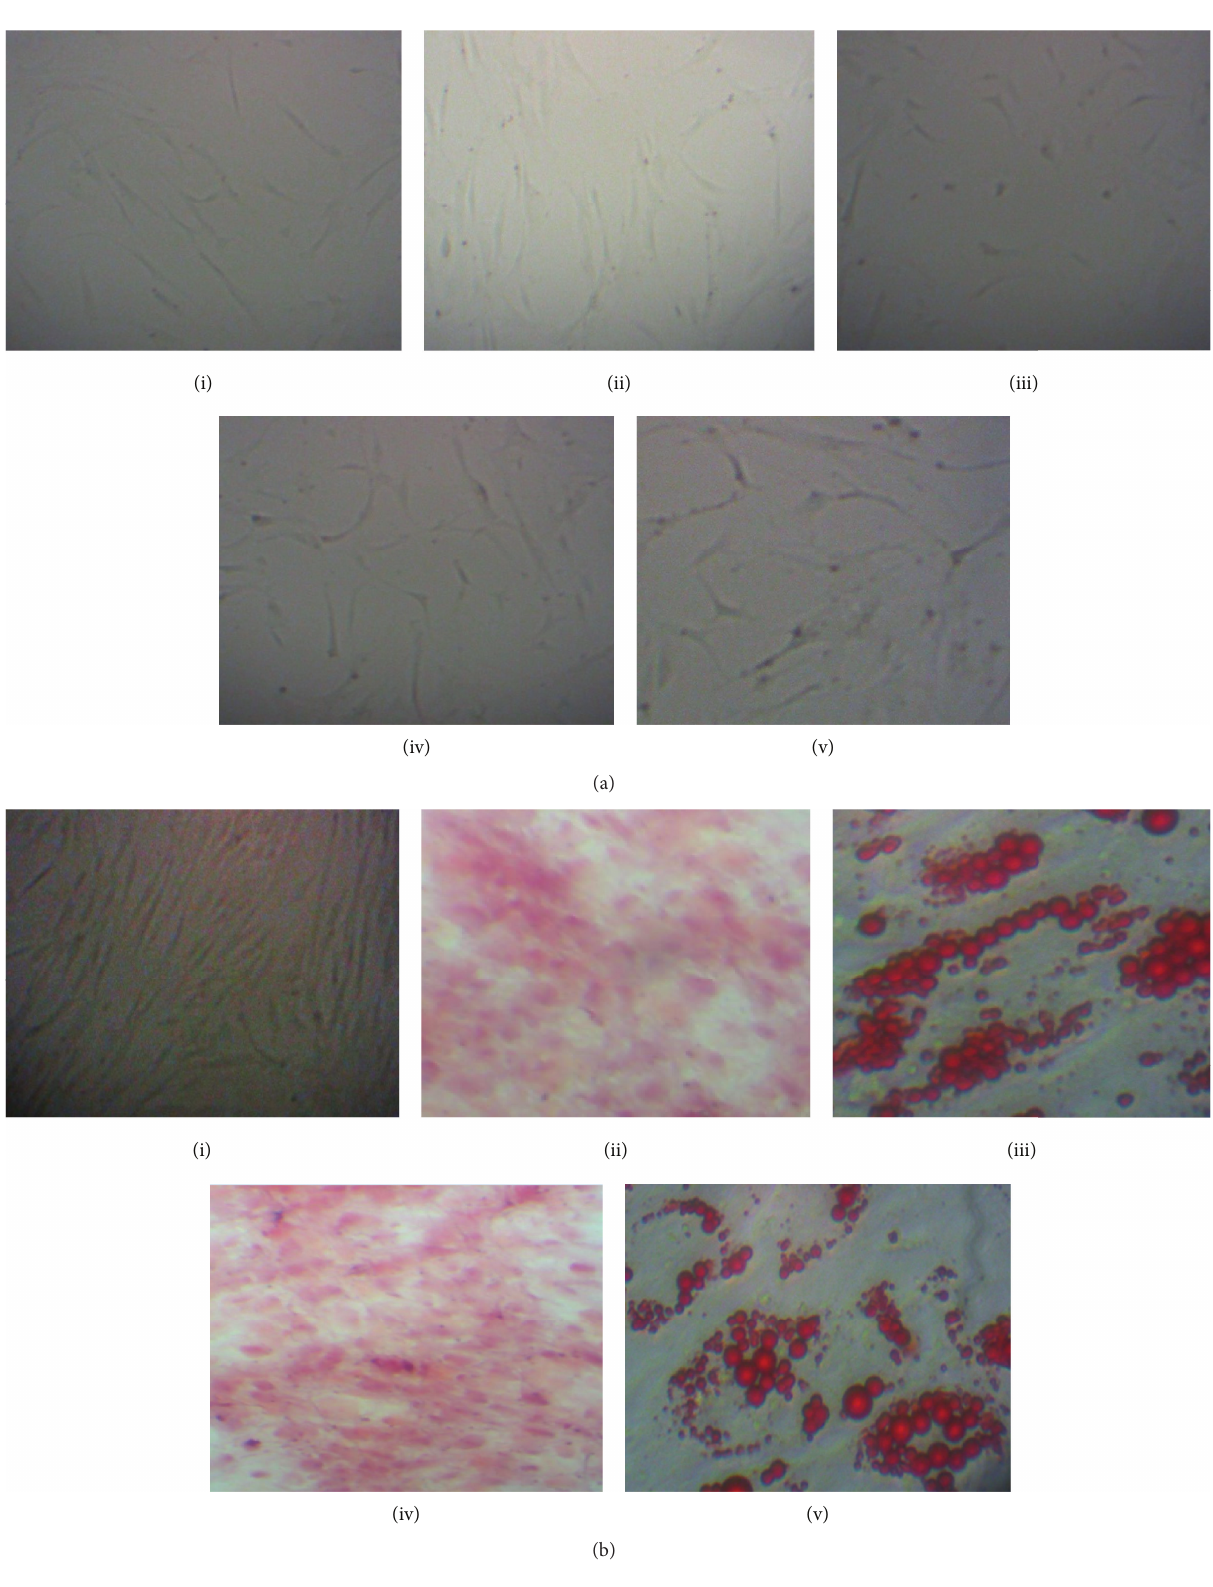
Figure 1: Morphology and differentiation ability of MSCs isolated from controls and MDS patients. (a) Morphology of control and MDS- MSCs. P3 cells of (i) control, (ii) RCUD, (iii) RCMD, (iv) RAEB, and (v) MDS del(5q) at day 4 in culture (20x). (b) (i) Undifferentiated P3 MSCs. (ii) and (iv) are alizarin red stained osteoblasts of control and a MDS patient (14-080) (4x). (iii) and (v) are differentiated control MSCs and MDS-MSCs towards adipogenic cells (40x) as stained with Oil Red